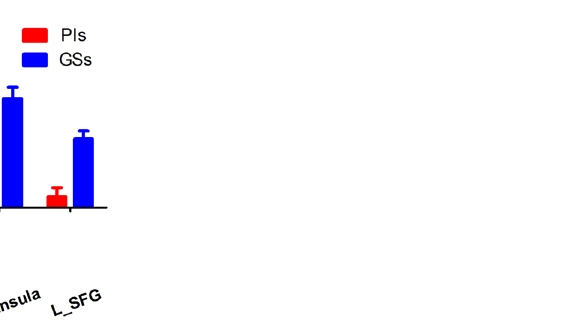
Figure 5. Binarized degree centrality value of between-group differences in different brain areas. Note: Data are mean ± standard error values. Abbreviations: PIs, Patients with primary insomnia; GSs, Good sleepers; R, right; L, left; OL, Occipital lobe; MTG, Middle temporal gyrus; SFG, Superior frontal gyrus.